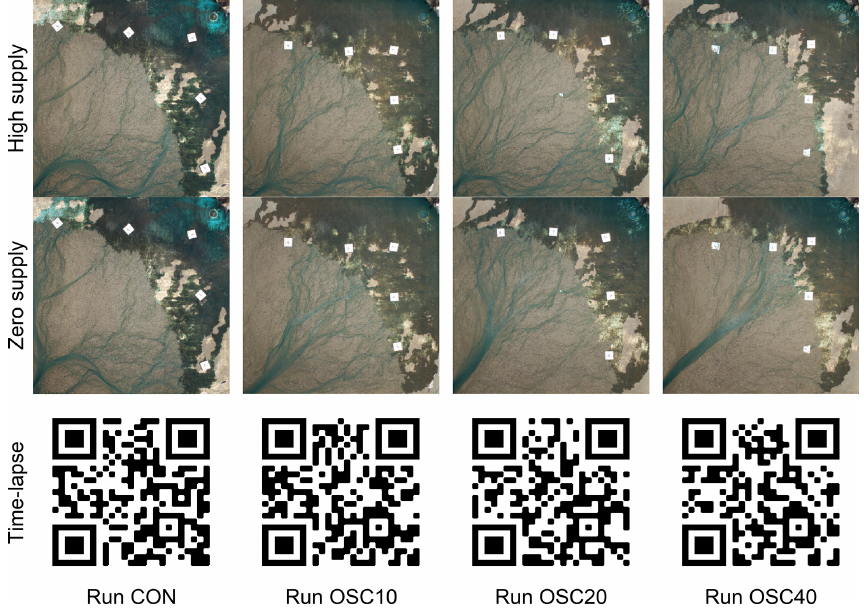
Figure 4. Example fan morphology after a period of high sediment supply (upper row panels) and zero sediment supply (middle row panels). Note that Run CON had no supply oscillations but has been sampled at the same time stamps as Run OSC10 for comparison. Lower row: QR codes that link to each experimental time-lapse video. The videos are also available at https://youtu.be/ML2LV28MQEM (last access: 3 November 2022) (Run CON), https://youtu.be/jXjWIkLU-7A (last access: 3 November 2022) (Run OSC10), https://youtu.be/ T4JbZC9YkXQ (last access: 3 November 2022) (Run OSC20), and https://youtu.be/EcCWYGIbsqA (last access: 3 November 2022) (Run OSC40).